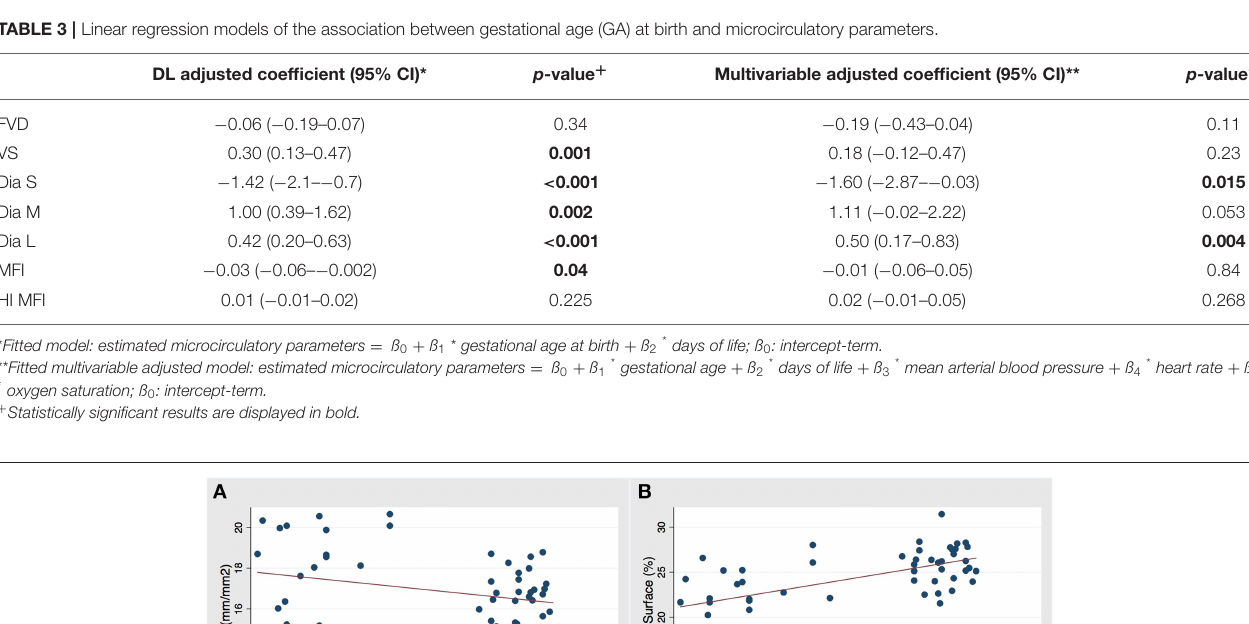
FIGURE 1 | (A) FVD and (B) distribution of diameters in the term vs. preterm infant group. Data are presented as box-plots with median, minimal and maximal values. FVD in the preterm group was statistically significantly higher than in the term group ( p = 0.046). The percentage of small diameter vessels was statistically significantly higher in the preterm group, whereas the percentage of medium and large vessels was statistically significantly lower in the preterm group ( p < 0.0001).